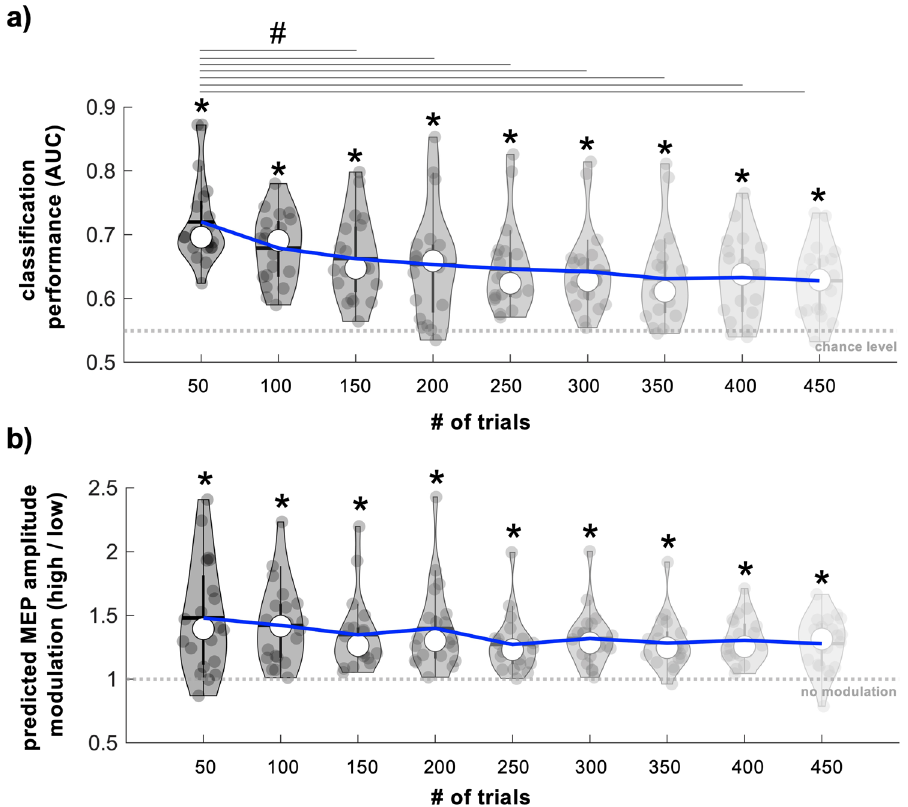
Figure 6. Influence of trial number on classifier performance and classifier-predicted MEP amplitude modulation. ( a ) AUC values reflecting performance of classifiers trained and tested using varying dataset sizes. AUC values exceeded empirical chance for all dataset sizes. However, AUC values obtained from classifiers built using 50 trials were significantly larger than AUC values obtained from classifiers built using 150, 200, 250, 300, 350, 400, or 450 trials. The grey dashed line indicates empirical chance level. * Indicates statistical significance of AUC values when compared to empirical chance. # Indicates significant pairwise comparisons. ( b ) Classifier- predicted MEP amplitude modulation obtained from classifiers built using varying dataset sizes. Predicted MEP amplitude modulation (classifier-predicted high MEP amplitudes/classifier-predicted low MEP amplitudes) was larger than 1 for all dataset sizes and did not differ across dataset sizes. The grey dashed line indicates no MEP amplitude modulation. * Indicates statistical significance of predicted MEP amplitude values when compared to 1. For both panels, blue lines indicate group means for each dataset size. Grey dots represent individual participant values, thick whiskers represent interquartile range, thin whiskers represent full range, white dots represent the group median and grey/black horizontal lines represent group